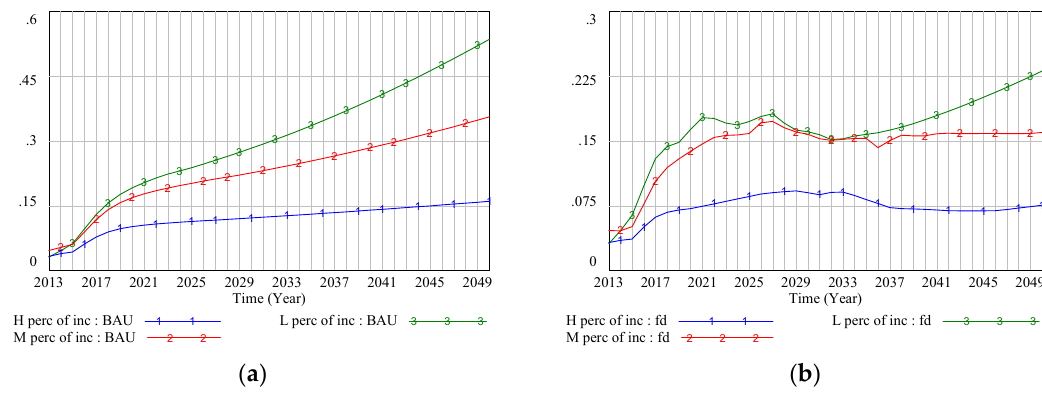
Figure 6. ( a ) Medical costs as a proportion of income (BAU scenario); ( b ) medical costs as a proportion of income (FD scenario). Note: BAU scenario: SES–health disparity scenario; FD scenario: SES–FD–